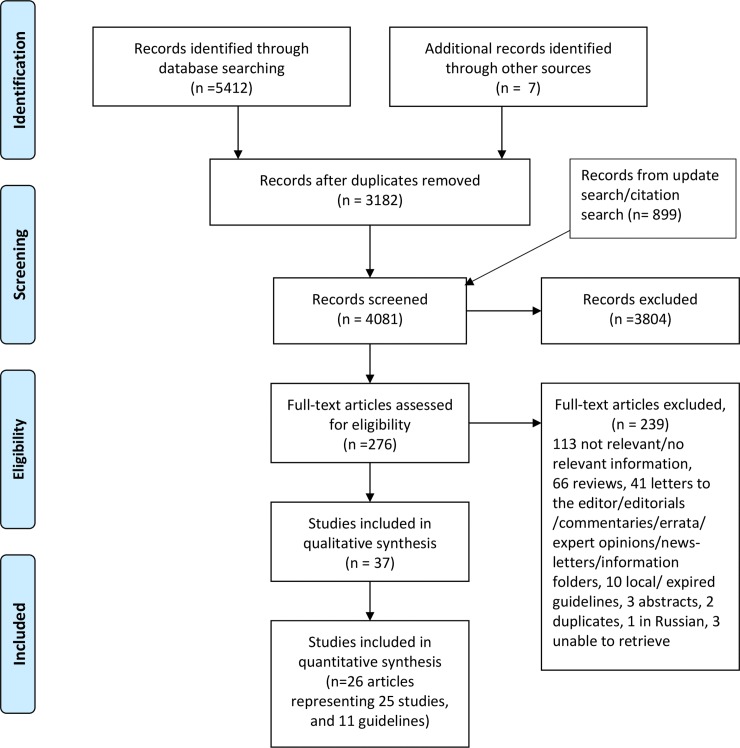
PRISMA flow diagram of included studies.